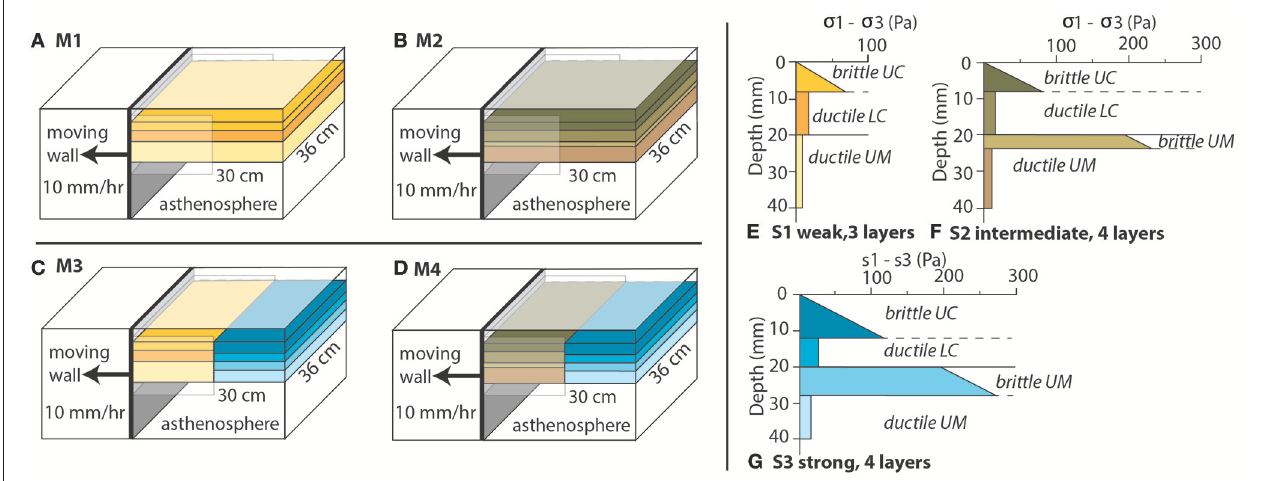
FIGURE 2 | Experimental setup of the four analog models (A–D) with rheological strength envelopes (E–G) . (A) Model 1 (M1), lateral homogeneous stratified strength profile S1 (weak, three layers, E ). (B) Model 2 (M2), lateral homogeneous stratified strength profile S2 (intermediate, four layers, F ). (C) Model 3, lateral variation in strength profile combining vertically stratified strength profile S1 (weak, three layers, E ) and S3 (strong, four layers, G,D ) Model 4, lateral variation in strength profile combining vertically stratified strength profile S2 (intermediate, three layers, E ) and S3 (strong, four layers, ( G) ). The black arrow indicates the direction of the moving wall (10 mm/h, constant rate) that also holds the box-in-box construction. The layered lithosphere floats on a low viscosity high density fluid within the Plexiglas box. UC, upper crust; LC, lower crust; UM, upper mantle .